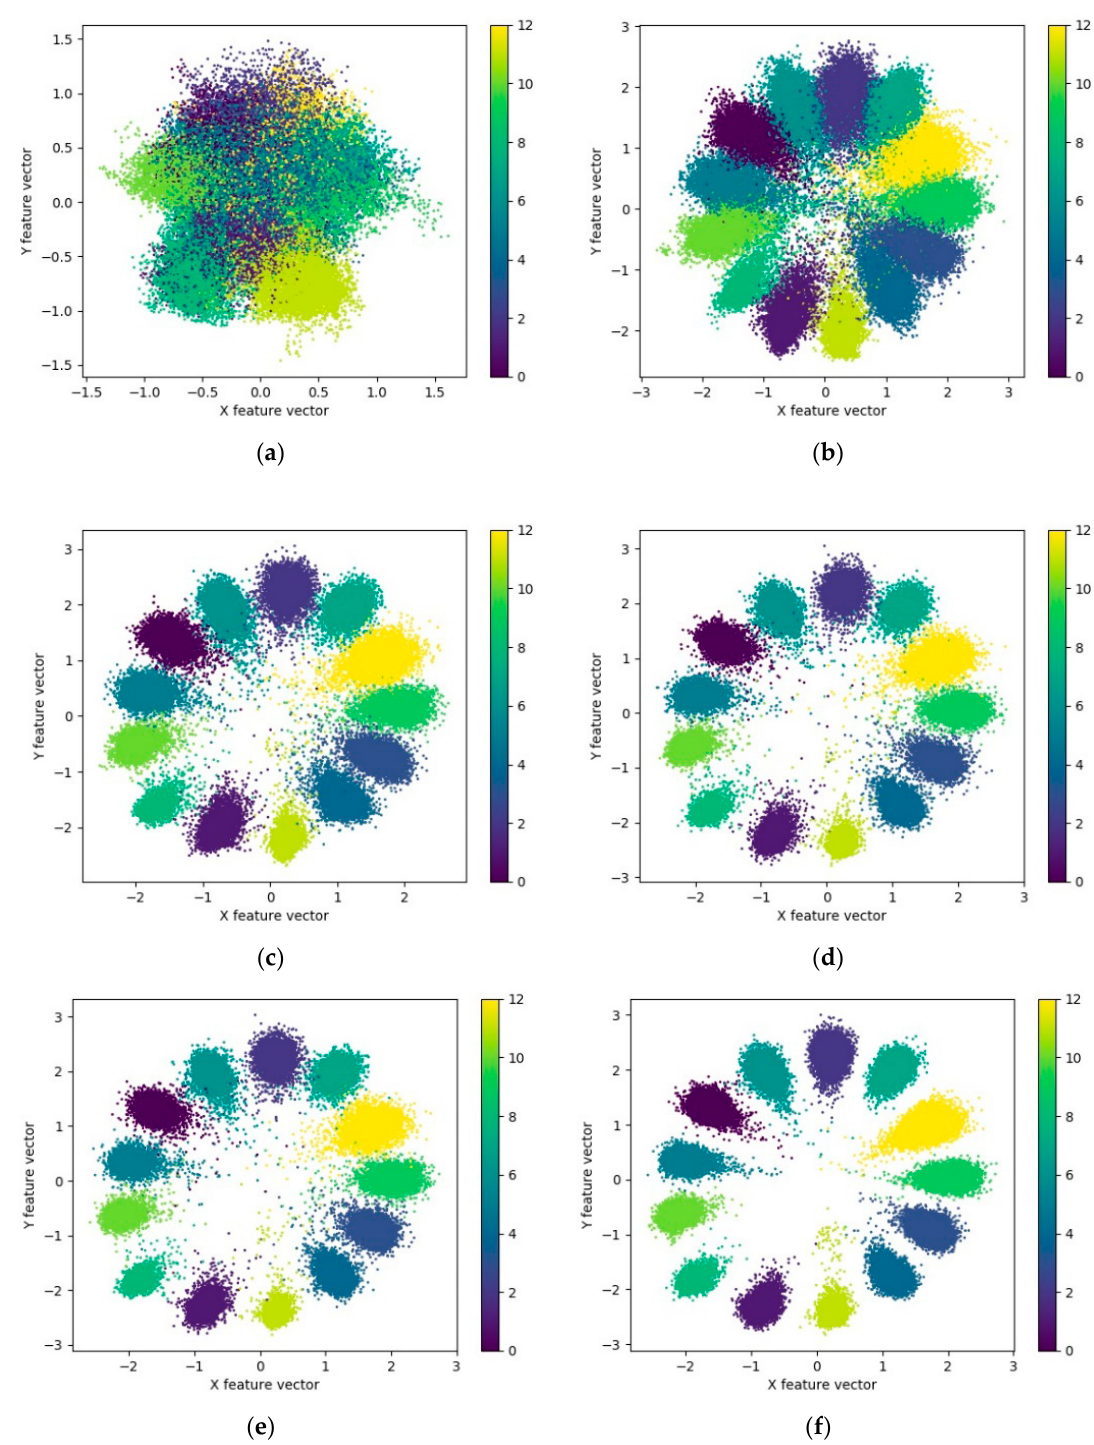
Figure 10. Visualization of the feature extracted by model A with the loss function L SC during training. ( a – e ) Feature visualization of testing dataset, and ( f ) feature visualization of training dataset. ( a ) Iterations = 1 and recognition accuracy = 0.3274; ( b ) Iterations = 50 and recognition accuracy = 0.9489; ( c ) Iterations = 100 and recognition accuracy = 0.9968; ( d ) Iterations = 150 and recognition accuracy = 0.9968; ( e ) Iterations = 200 and recognition accuracy = 0.9972; ( f ) Iterations = 200 and recognition accuracy = 0.9988.